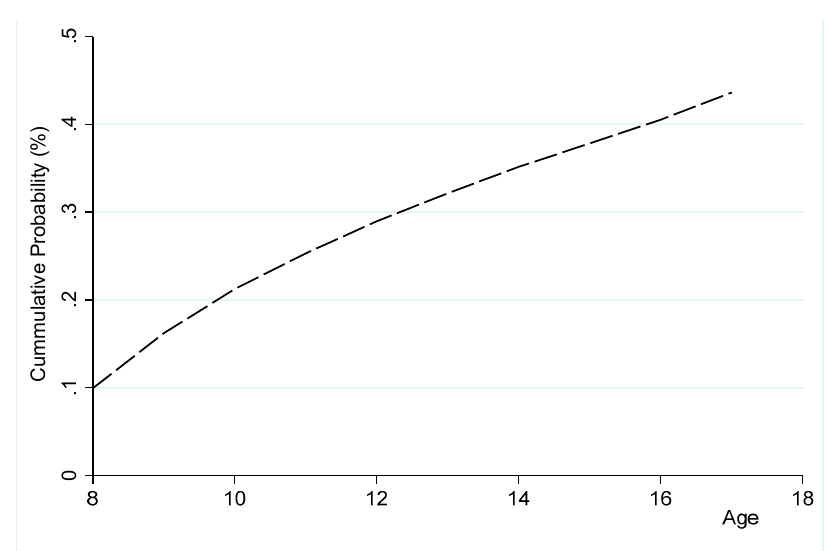
Figure 1. Cumulative risk of initiation into the use of tobacco products among youth (ages 8–17) in Ghana.